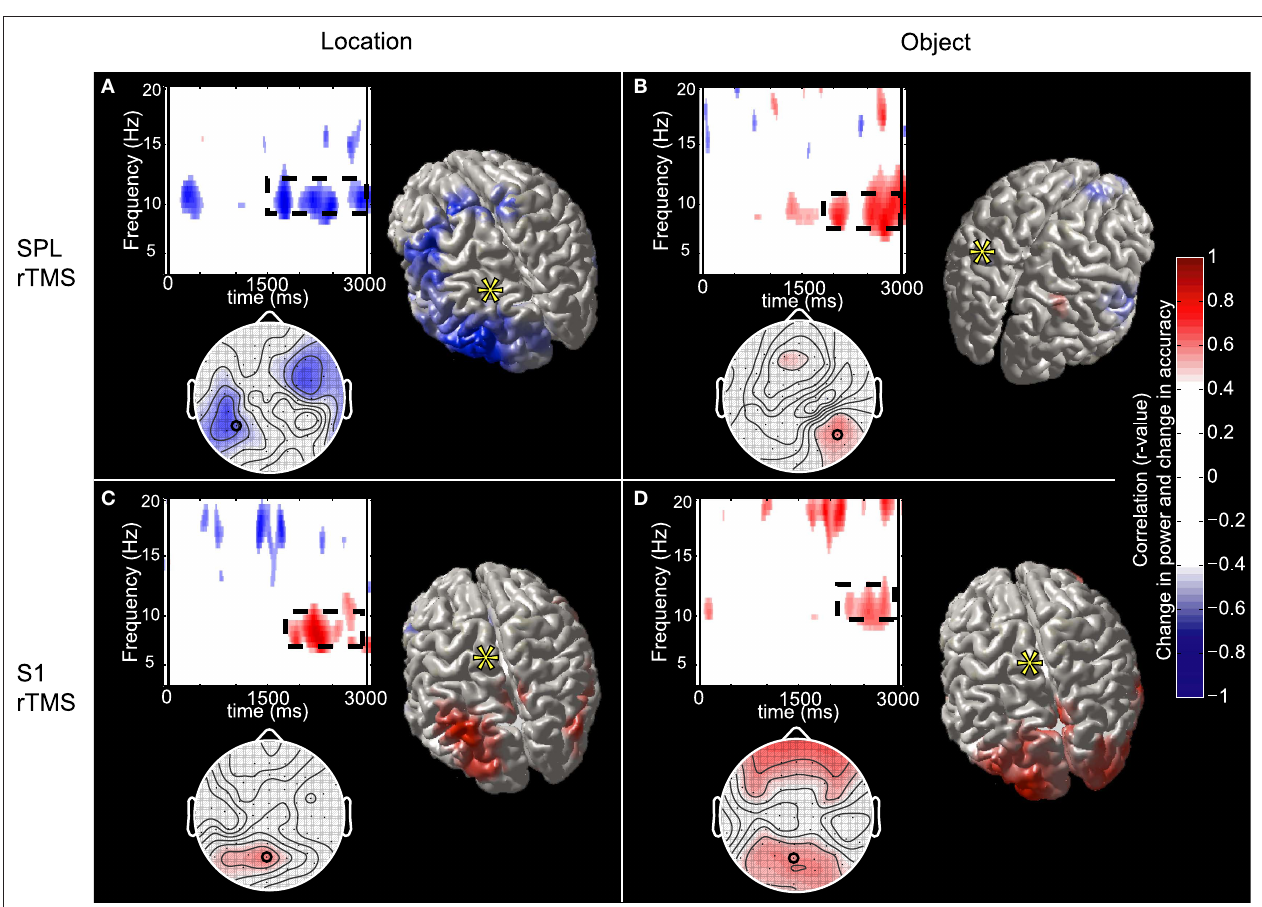
FIGURE 5 | Topographic and source maps of correlations between rTMS-induced change in alpha-band power and accuracy. (A) With SPL rTMS, during location memory trials, there was a negative correlation between rTMS-induced change in alpha-band power and accuracy. These correlations originated from three cortical sources: a large region of cortex extending from the left inferior parietal lobule, along the intraparietal sulcus (BA 39) to the left extrastriate cortex (BA 18), a region covering the left precentral sulcus (BA 6) and superior frontal gyrus, which included the putative frontal eye fi elds, as well as a region in the right medial temporal lobe corresponding to the hippocampus (not shown). (B) With object memory trials there was a positive correlation between effect of rTMS on alpha-band power and accuracy that was localized to a small area in the right calcarine fi ssure (not shown). There was also a region showing a negative correlation at the anterior region of the superior frontal sulcus (BA 9). (C,D) With S1 rTMS, for both memory tasks, there was a positive correlation between rTMS-induced change in alpha-band power and rTMS-induced change